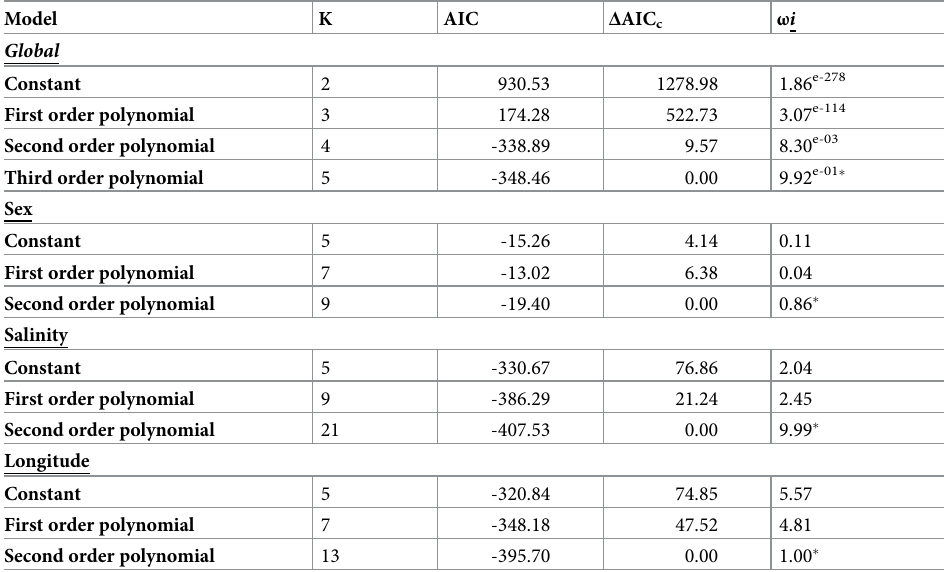
Table 2. Model selection table for growth analysis of American crocodiles ( Crocodylus acutus ) in South Florida.